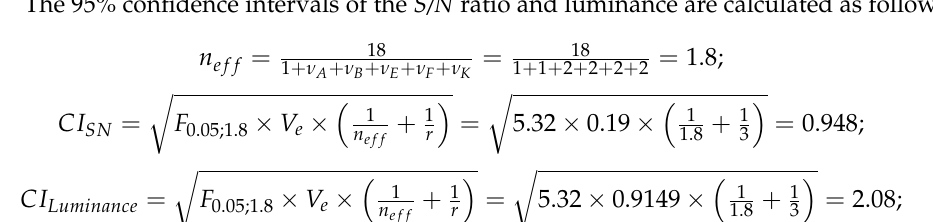
Table 14. Results of the confirmation experiments for the Taguchi Method. Control Factors EXP.